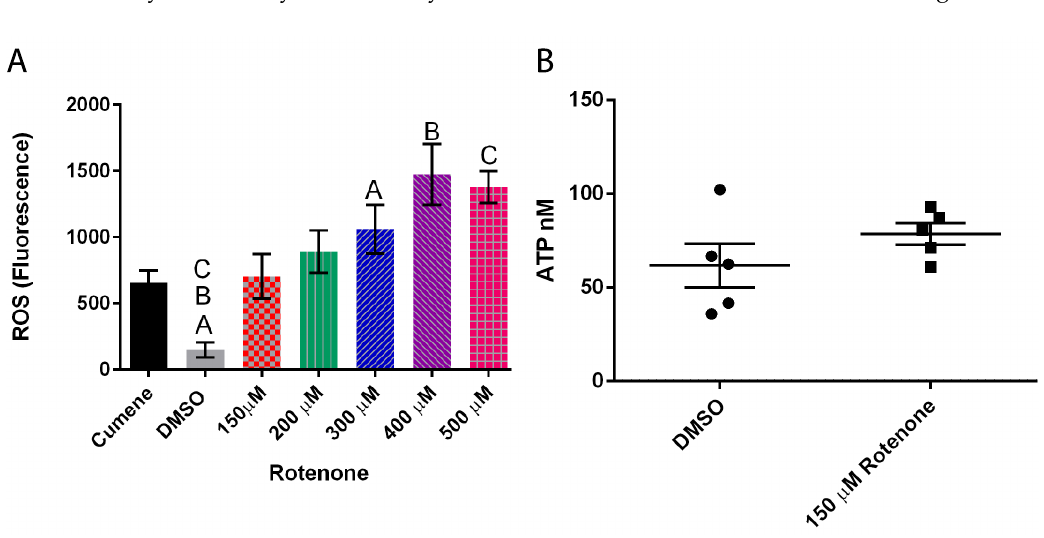
Figure 5. Effect of rotenone on reactive oxygen species (ROS) and ATP levels in Dictyostelium discoideum . ( A ) Increasing rotenone increases ROS ( n = 6) ( p = 0.0003), Columns with same letter are significantly different from each other, standard error is represented by the error bars on each column. ( B ) Addition of 150 µ M rotenone had no significant effect on ATP levels ( n = 5). The scatter columns represent all data points, average, and standard